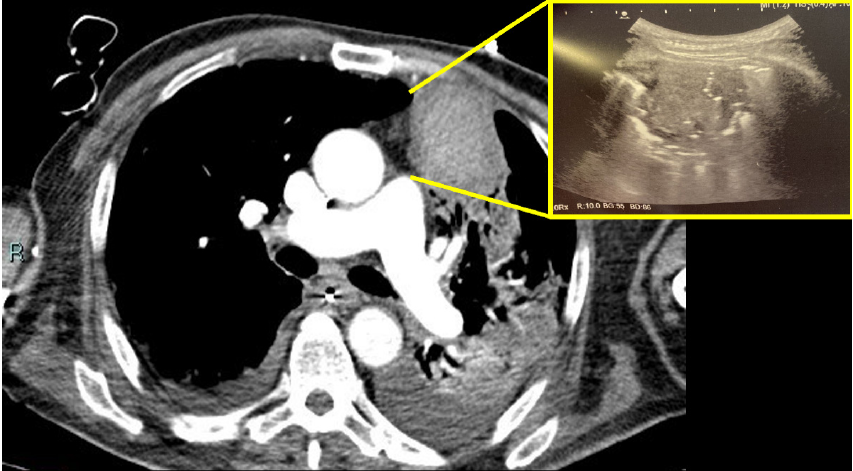
Figure 3. Lung bedside ultrasound evaluation and chest CT scan during ICU stay. Legend: with ultrasound, oval hypoechoic mass of about 5.2 cm × 4.4 cm in left upper anterior zone, characterized by some hyperechoic spots inside (Figure 3, yellow box), suggestive of hematoma. This finding was confirmed by chest CT scan, which showed a hyperdense bloody mass.